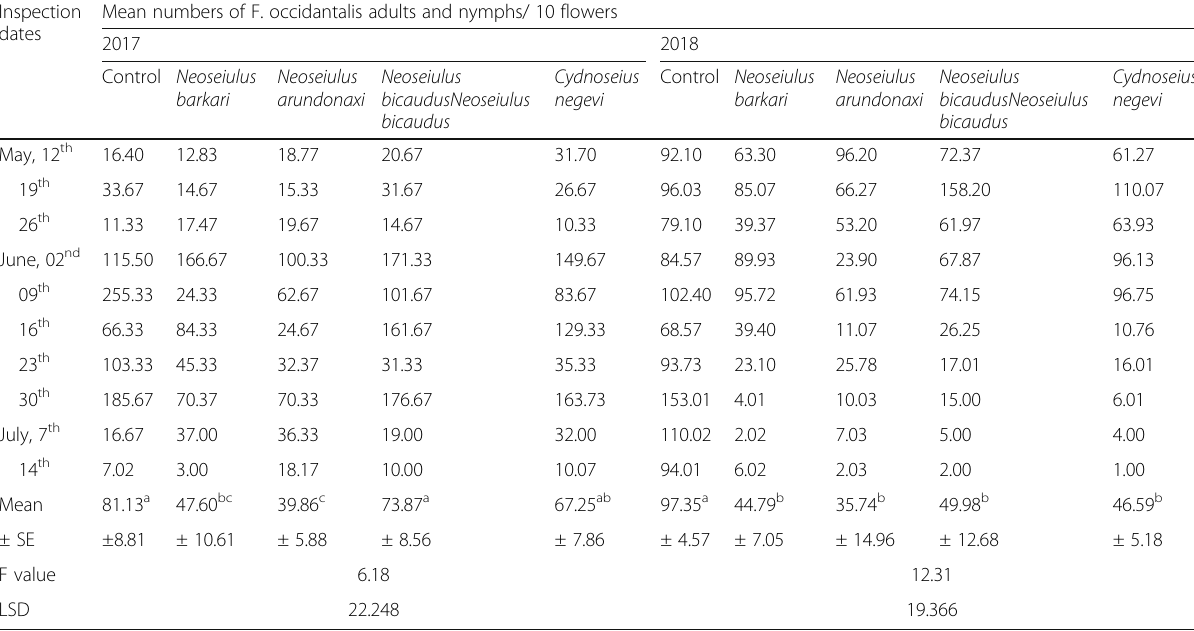
Table 3 Mean number of Frankliniella occidentalis adult and nymphs after the releasing of the four phytoseiid mites at tenth week after plantation on pepper greenhouse during the two seasons of 2017 and 2018 Inspection